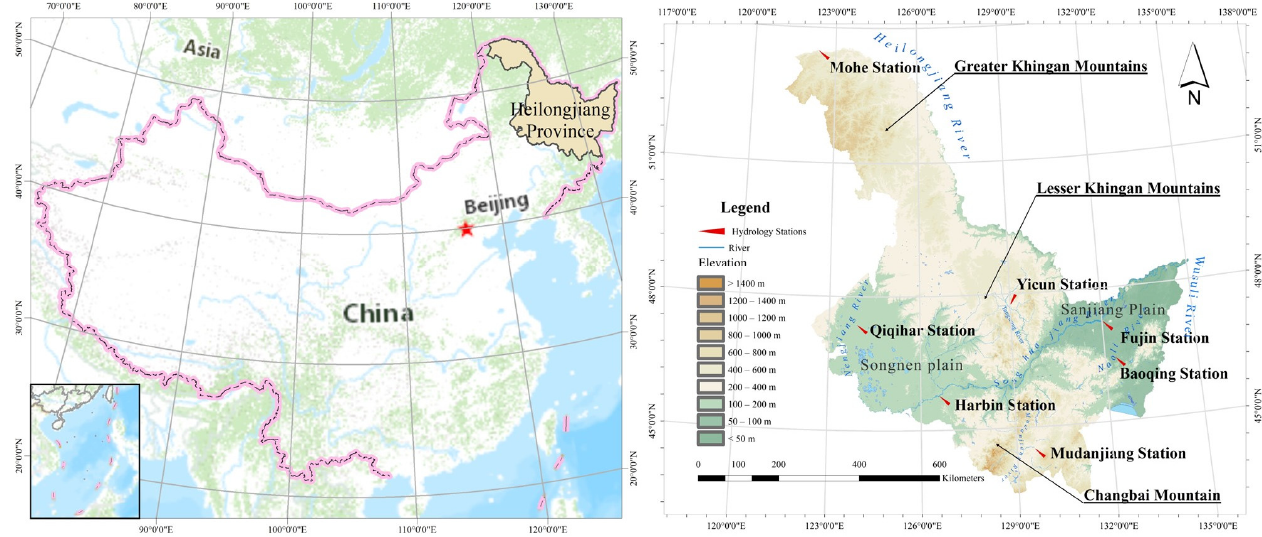
Figure 1. Study area and representative stations (The red star represents the capital of China). The break-up date series of Mohe hydrological station (MH), Yichun hydrological station (YC), Mudanjiang hydrological station (MDJ), Qiqihar hydrological station (QQHR), Harbin hydrological station (HRB), Fujin hydrological station (FJ), and Baoqing hydro- logical station (BQ) were selected to study the break-up date forecast. Among these hydrological stations, MH, YC, and MDJ are located in Greater Khingan Mountains, Lesser Khingan Mountains, and Wanda Mountains, respectively. QQHR and HRB are located in the Songnen plain. FJ and BQ are located in the Sanjiang plain. Except for MH, which is located in the cold temperate zone, the other hydrological stations are located in a middle temperate zone. The length, time span, mean, standard deviation ( SD ), and range of the break-up date series of each hydrological station are shown in Table 1. As shown in Table 1, the break-up date series of all hydrological stations ended in 2019. Except for QQHR (length of 36) and YC (length of 47), the length of the break-up date series of other stations was about 60 years. Except for FJ, MH, and YC, breaking up in mid-late April (day 107–day 119), the break-up date of other hydrological stations is in early April (day 97 to day 101). Apart from BQ (standard deviation of 6.84, range of 45) and QQHR (standard deviation of 6.82, range of 34), the standard deviation of the break-up date series of other hydrological stations was less than 6, and the range (the difference between the earliest break-up date and the latest break-up date in the respective series) was less than 25